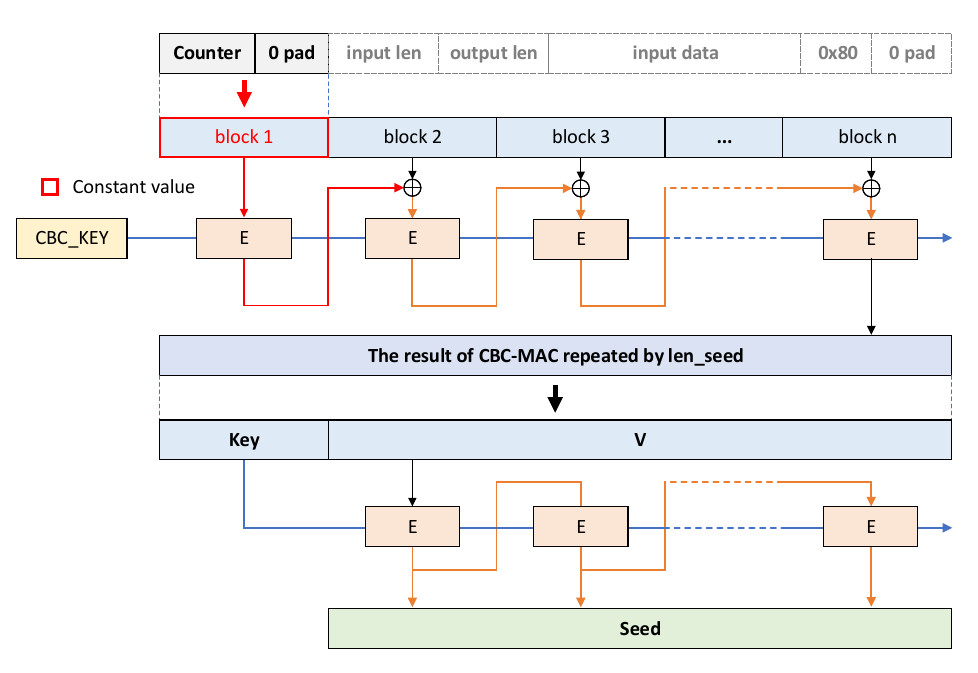
Figure 18. The part that can be constant value in the derivation